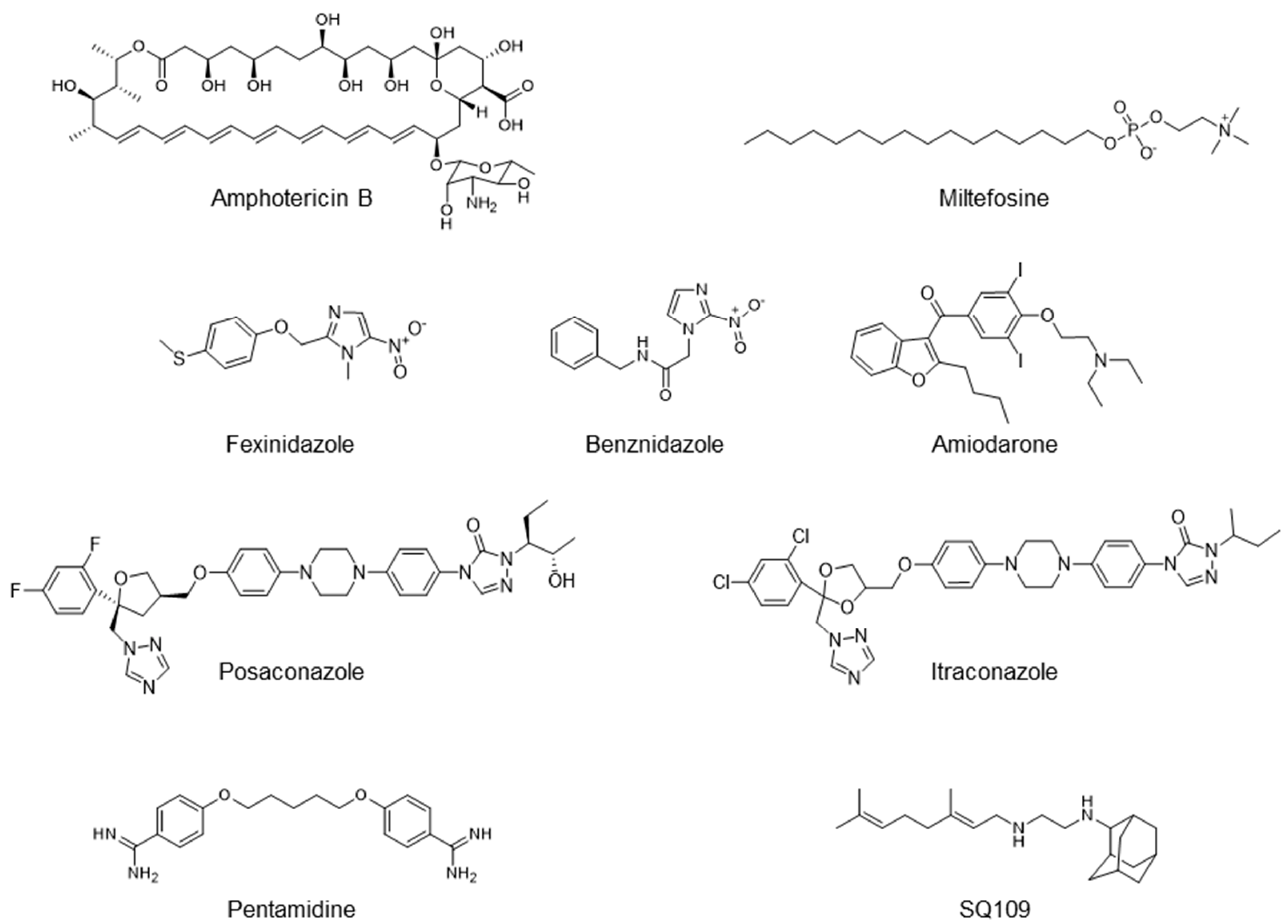
Figure 1. Structures of compounds described in this study.